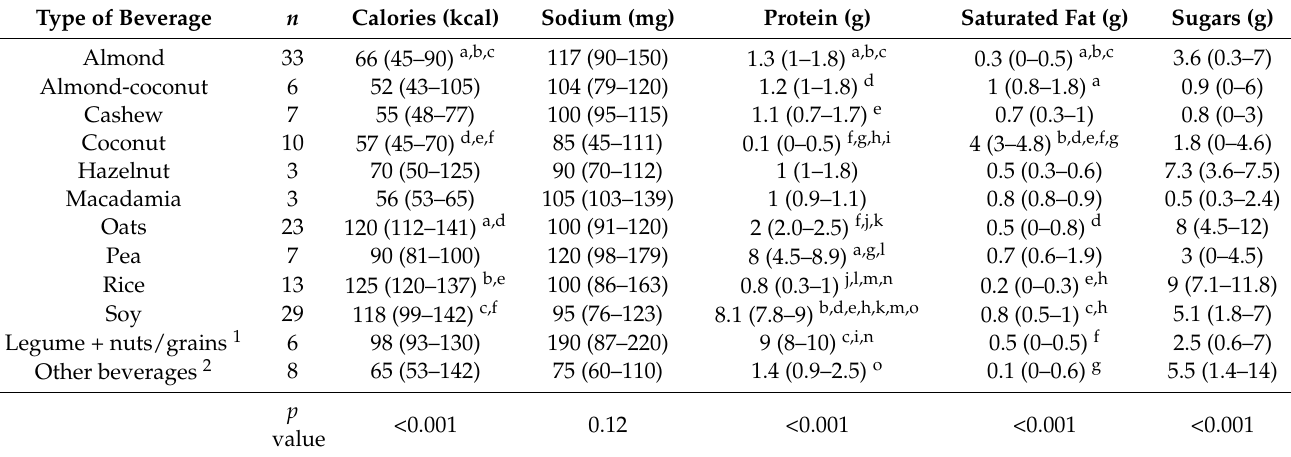
Table 6. Median (Q1–Q3) values of calories and selected nutrients in non-dairy beverages per serving, by type of beverage. Type of